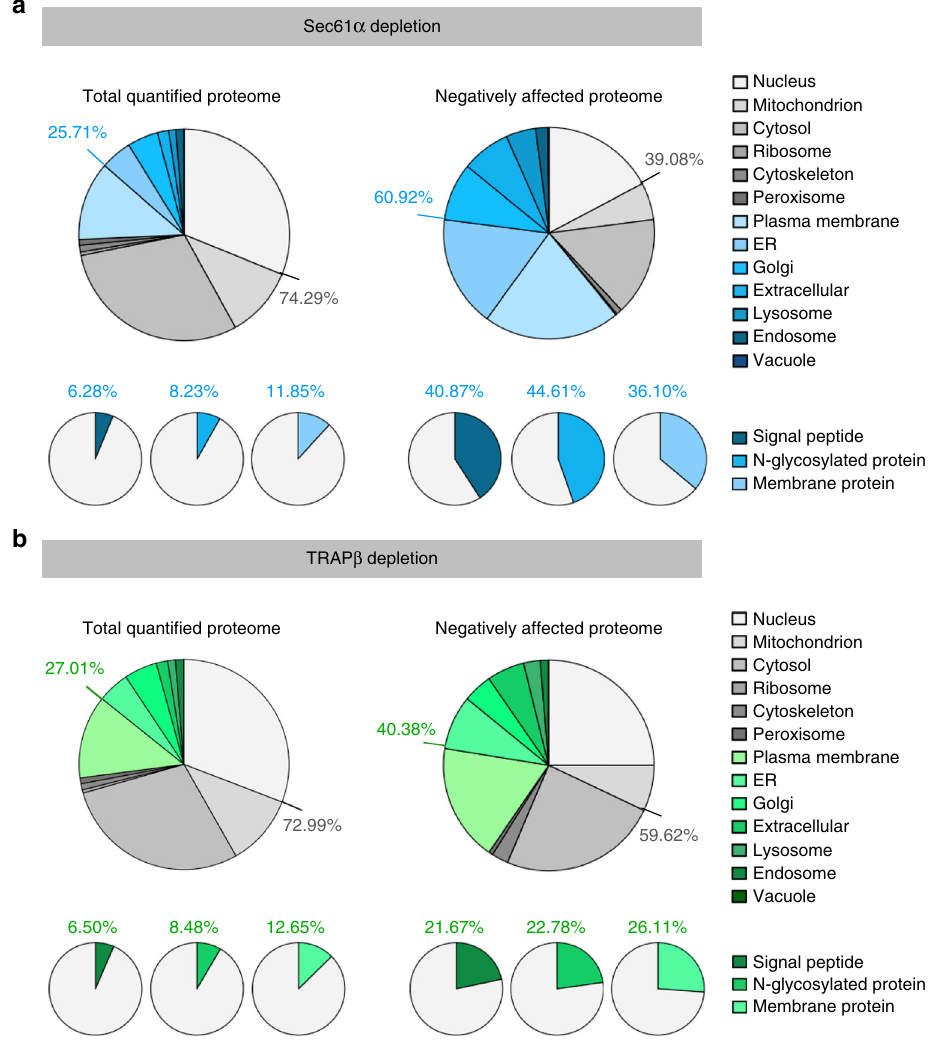
Fig. 2 Validation of TRAP clients based on Gene Ontology enrichment factors. The color coding follows Fig. 1. Protein annotations of signal peptides, membrane location, and N-glycosylation in humans were extracted from UniProtKB, and used to determine the enrichment of Gene Ontology annotations among the secondarily affected proteins. a , b Summaries of two Sec61 ( a ) and three TRAP depletion experiments ( b ), performed in triplicate in each